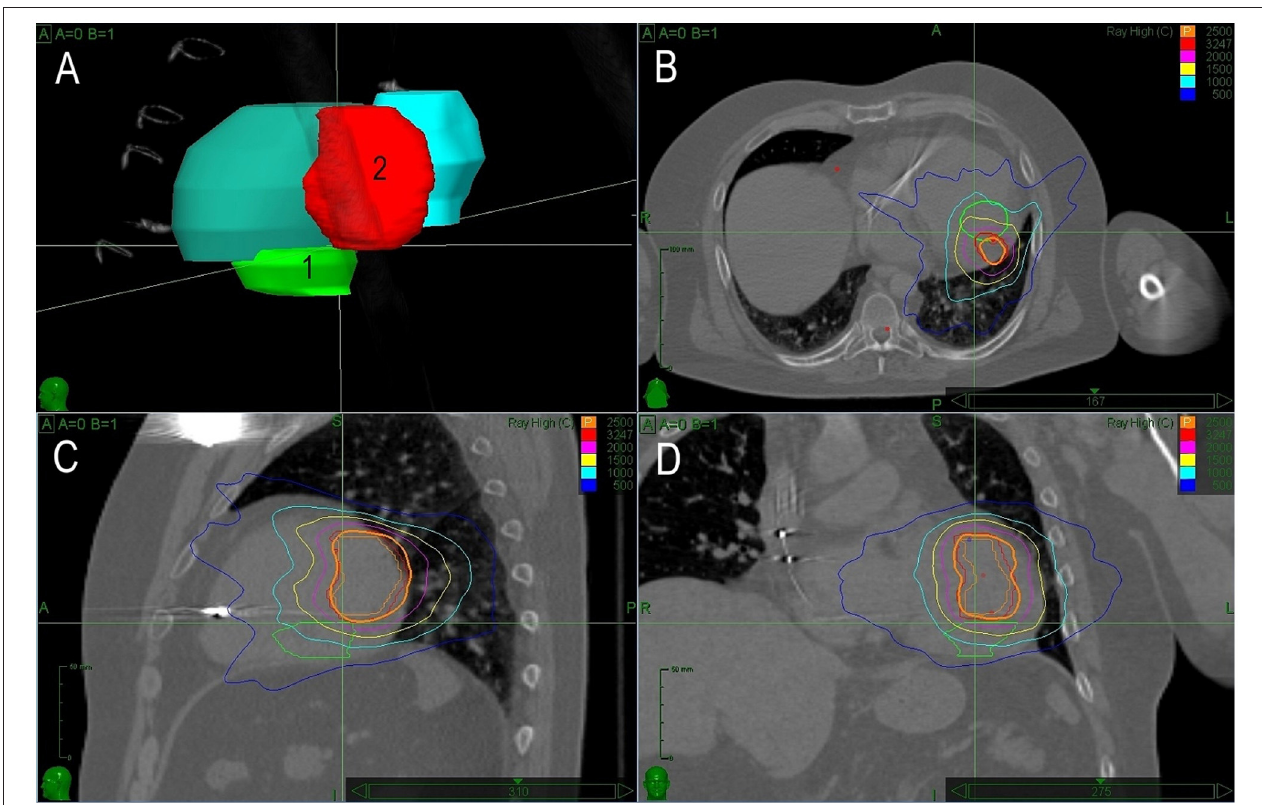
FIGURE 2 | The treatment plan for Case 2. Description of (A–D) is identical as in Figure 1 . In this case, the second planned target volume covers an entirely different